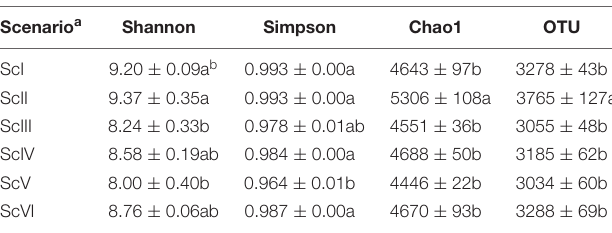
TABLE 2 | Bacterial diversity indices of six scenarios for clusters at ≥ 97% sequence similarity against the reference